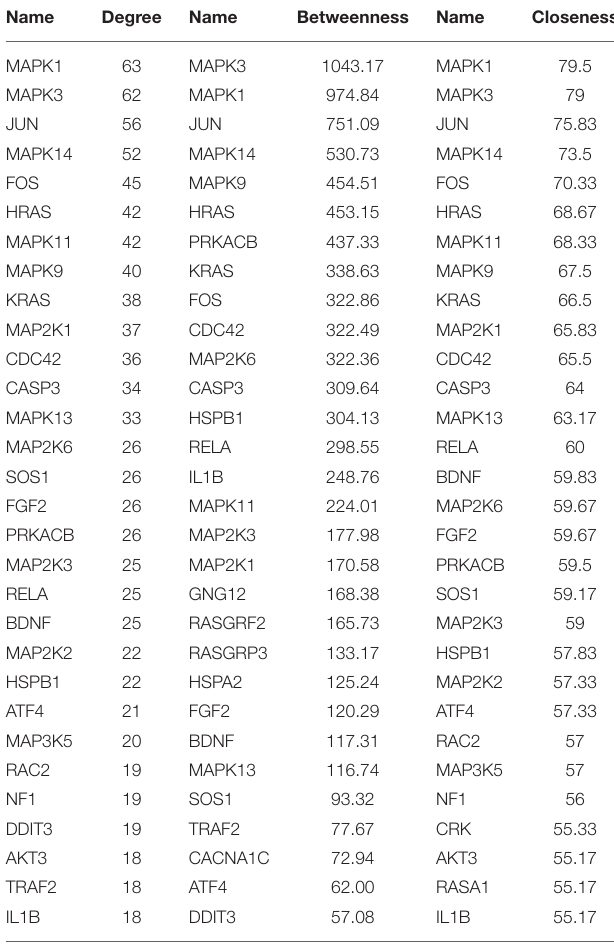
TABLE 4 | Top 30 nodes of PPI network in the MAPK signaling